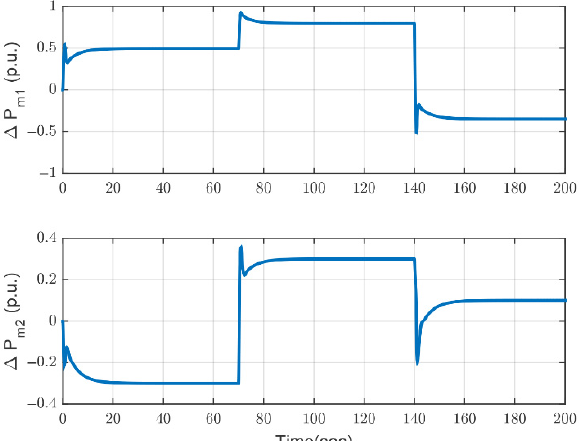
Figure 10. Frequency deviation of the proposed LFC controller during a random step load disturb- ance.